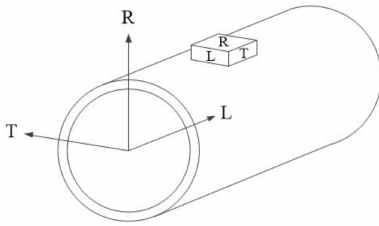
Figure 4. Metallographic structure sampling.